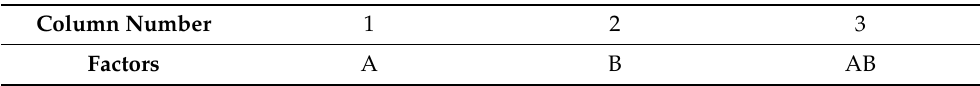
Table 5. The orthogonal testing header design of thermal characteristics of surface under swell conditions.